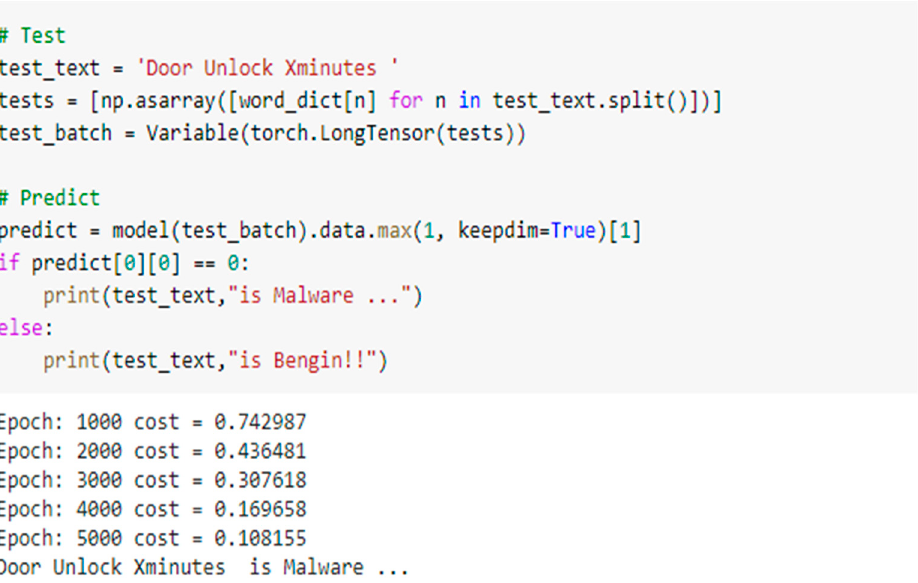
Figure 10. The test of the CNN phase at the HSAS-MD analyzer.